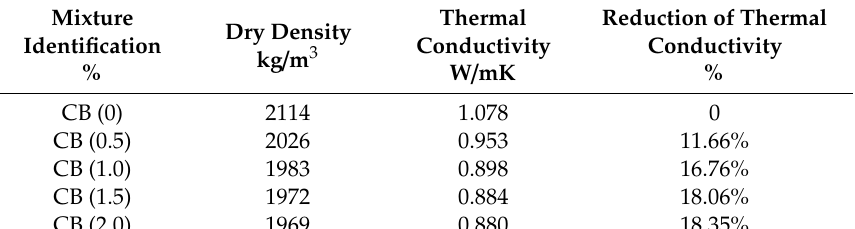
Table 3. Thermal conductivity of all estimated samples.